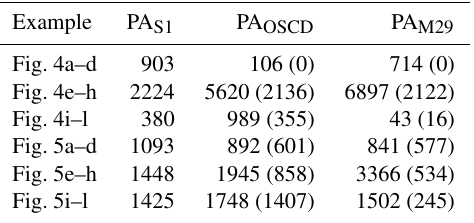
Table 3. Summary of polynya area (PA; in km 2 ) estimates between S1-A/B (PA S1 ), OSCD (PA OSCD ), and MOD/MYD29 (PA M29 ) data. PA estimates in parentheses correspond to the PA retrieved from MODIS for the S1-A/B polygon in Figs. 4 and